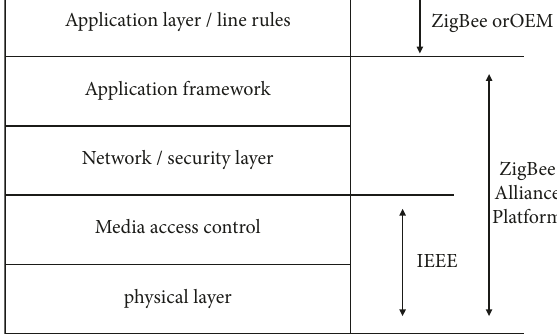
Figure 4: Star topology.